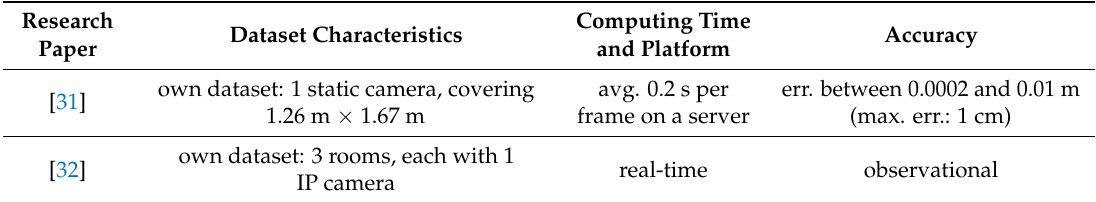
Table 2. Characteristics of indoor localization solutions with 2D static cameras (with known positions), markers, and traditional image